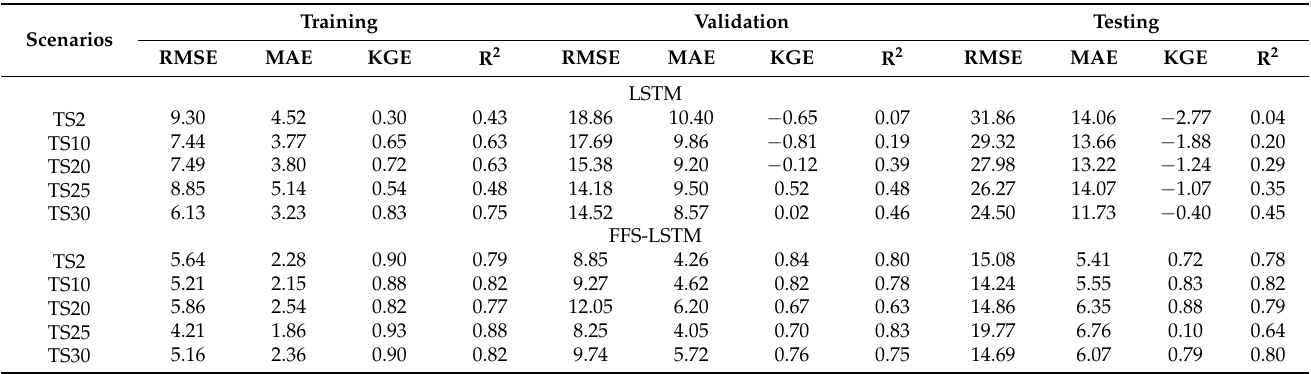
Table 4. Performance of the model scenarios for daily streamflow simulation using approach 1 (70% train; 15% valid; 15% test) with a variety of sequence lengths (number of time steps).